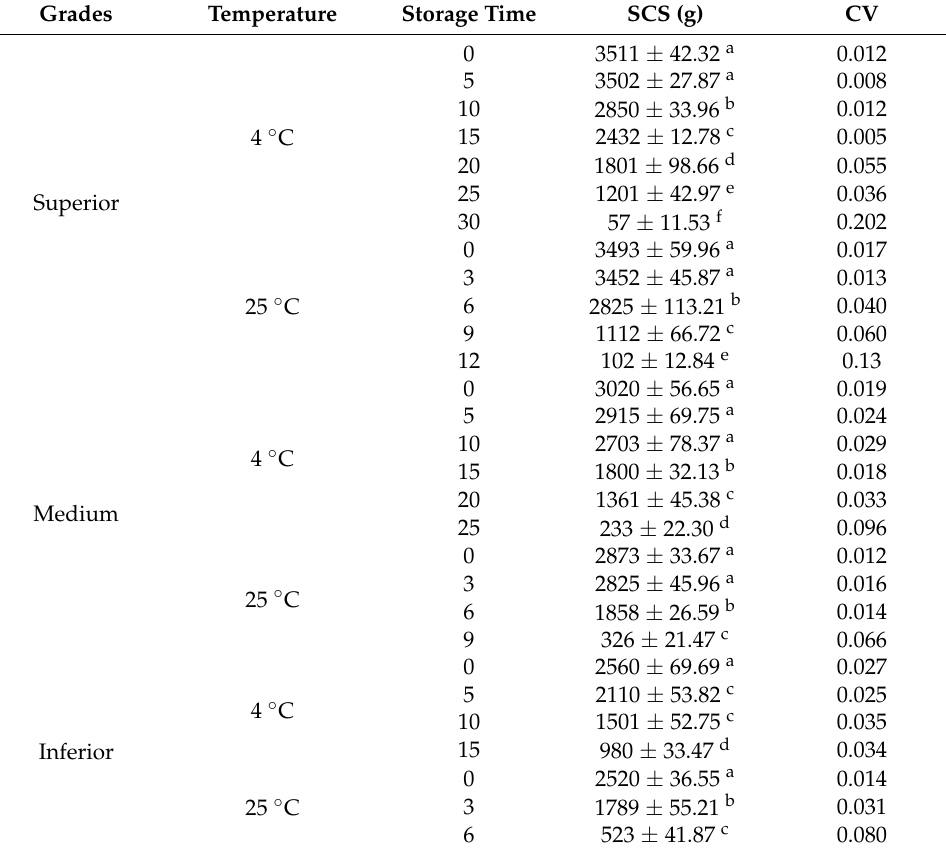
Table 1. Trends in oyster SCS over time for different grades and at different